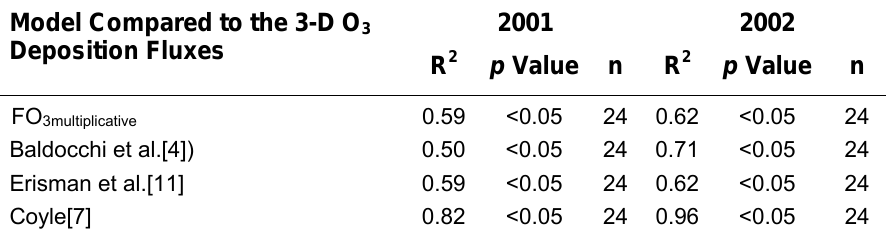
vs. Several Ozone Deposition and Regression Analysis for FO 3_3-D Stomatal Ozone Flux Models, for 2001 and 2002 2001 2002 Model Compared to the 3-D O 3 Deposition